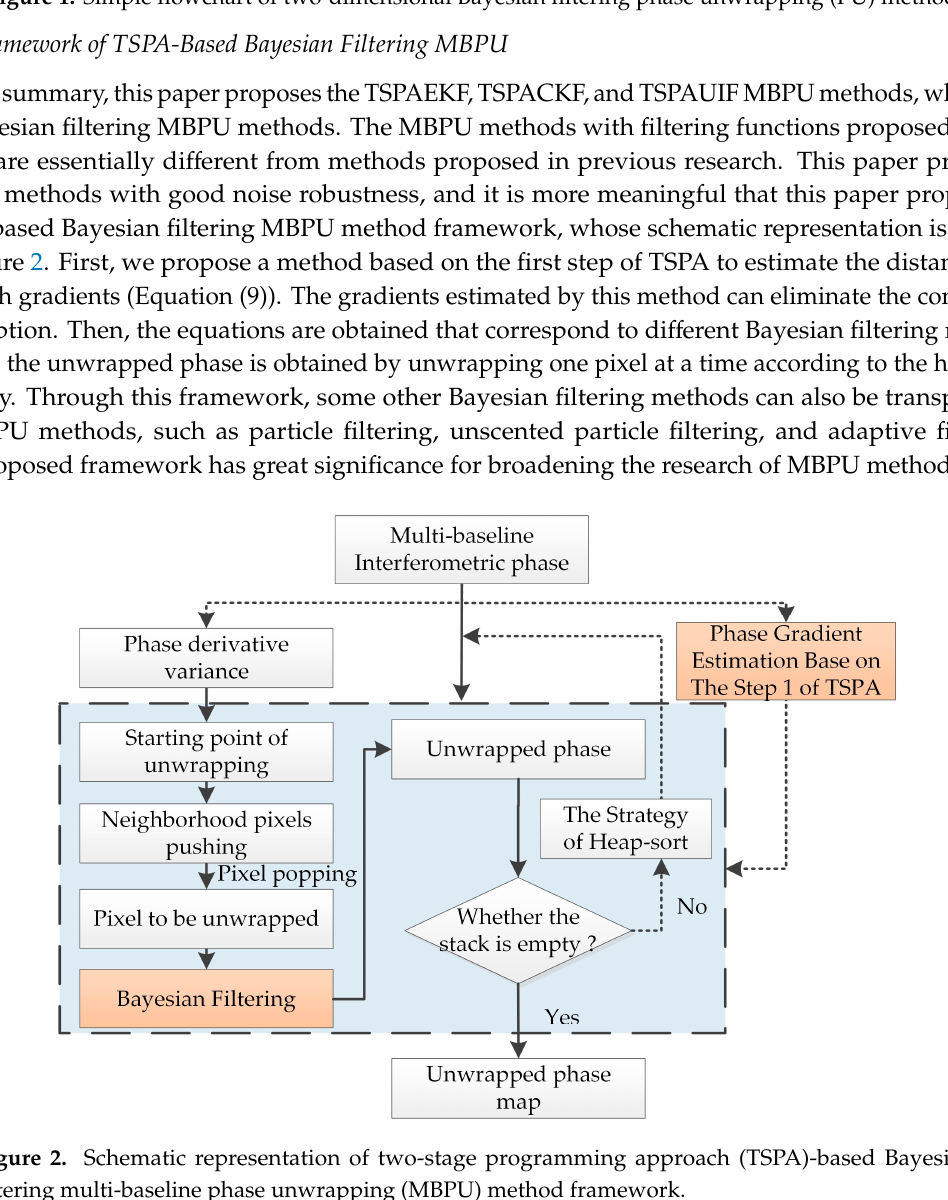
Figure 1. Simple flowchart of two-dimensional Bayesian filtering phase unwrapping (PU) method.